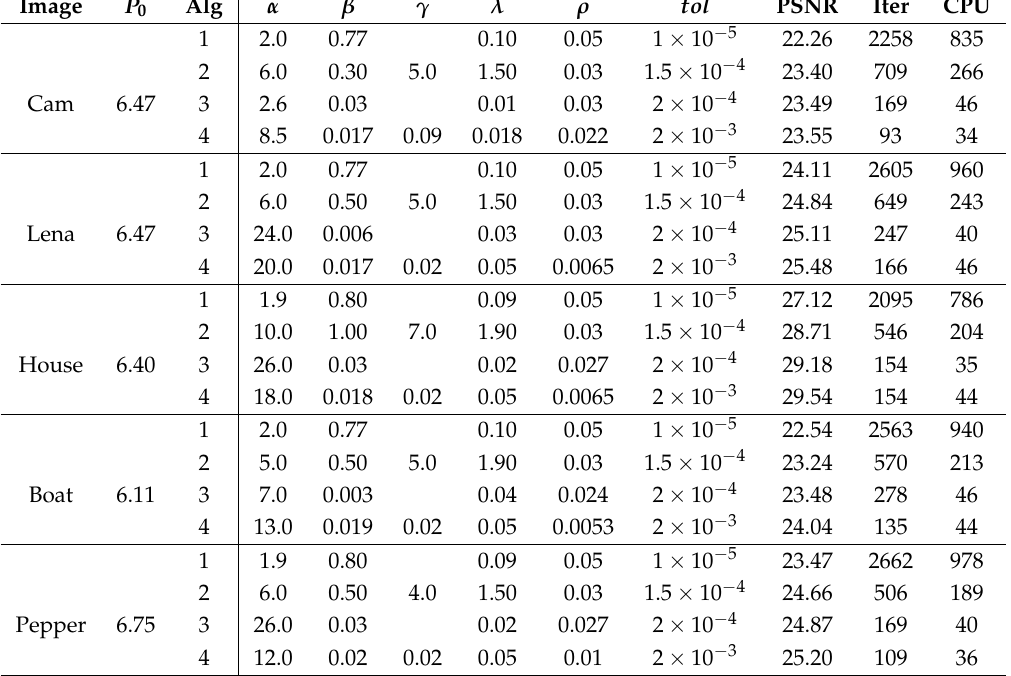
Table 4. Numerical results for TVL1 problems with 70% salt-and-pepper impulse noise.